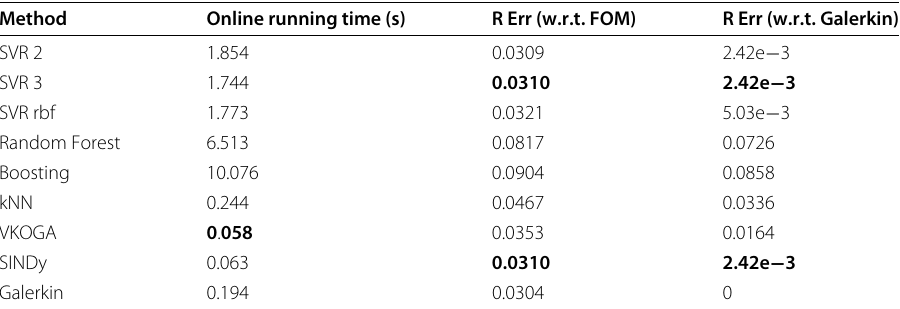
Table 2 Comparison of different machine learning methods using 4th-order Runge–Kutta for 1D inviscid Burgers’